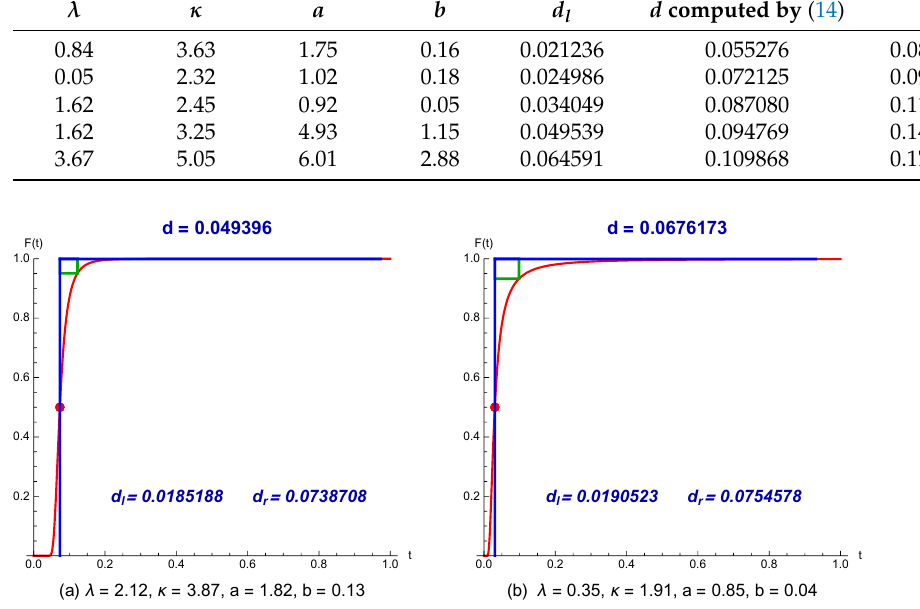
Figure 5. Approximation of CDF function of TCPOFL